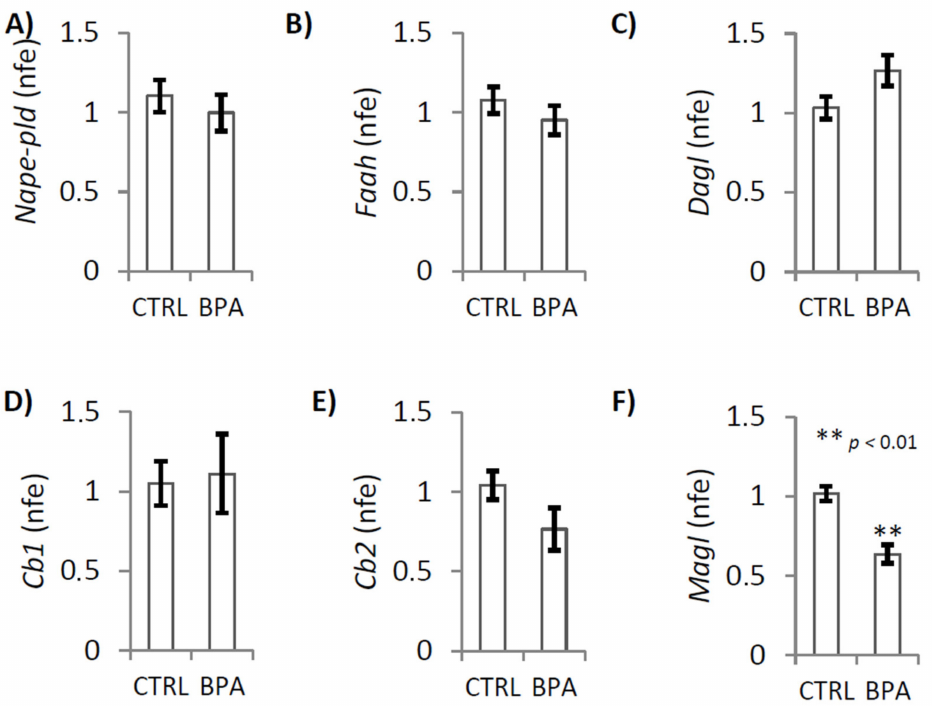
Figure 3. Gene expression analysis of ECS components in testis of male mice early-life exposed to vehicle (CTRL, n = 3/4) or BPA (BPA, n = 4) and sacrificed at 78 dpp . RTqPCR analysis of Nape- pld , Faah , Dagl , Cb1 , Cb2 , and Magl mRNA. Transcript amounts was reported as normalized fold expression (nfe) relatively to Rps18 gene ( A – F ). All the data were reported as mean value ± S.E.M. (**: p < 0.01).